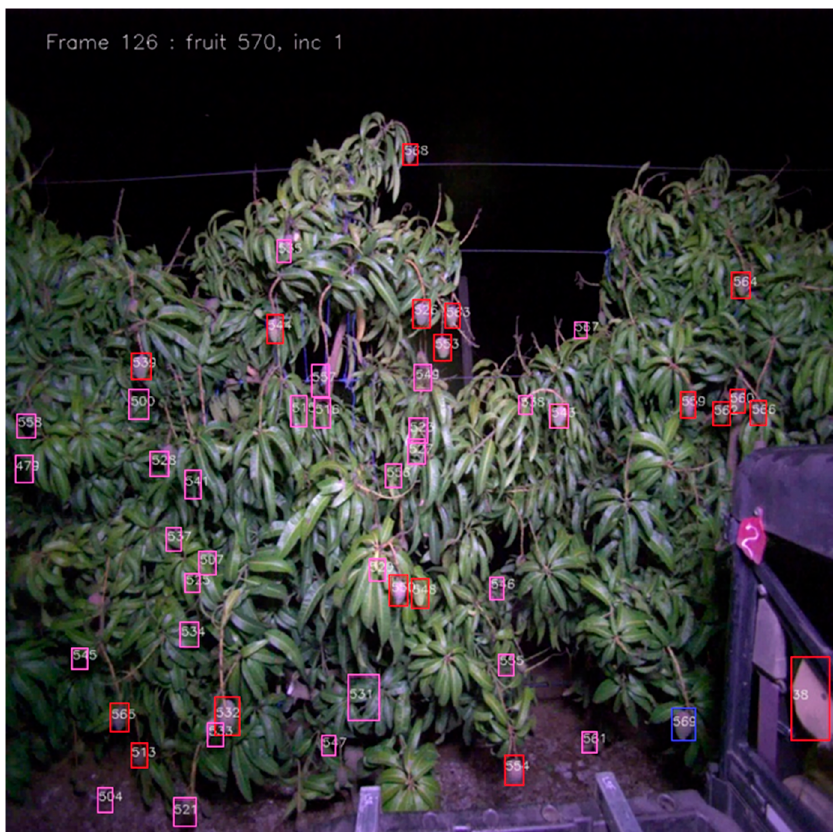
Figure 2. Image of trellised NMBP1243 canopy at Walkamin Research Facility. The MangoYOLO algorithm was used to classify and localize mango fruits in image. Blue bounding boxes represent a first detection on the current frame, red bounding box represents a fruit detected and tracked from previous frames and a pink bounding box is a tracking prediction of where a previous fruit detected could reappear.